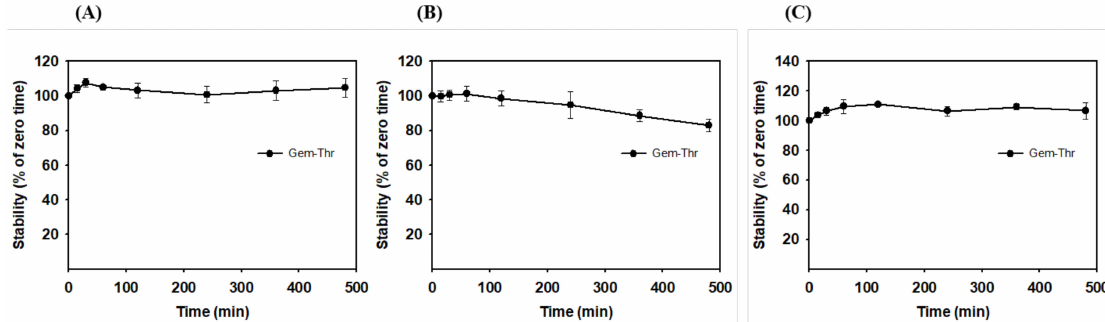
Figure 5. In vitro metabolic stabilities of Gem-Thr in PBS ( A ), plasma ( B ) and a liver microsome fraction ( C ) (mean ± SD, n =